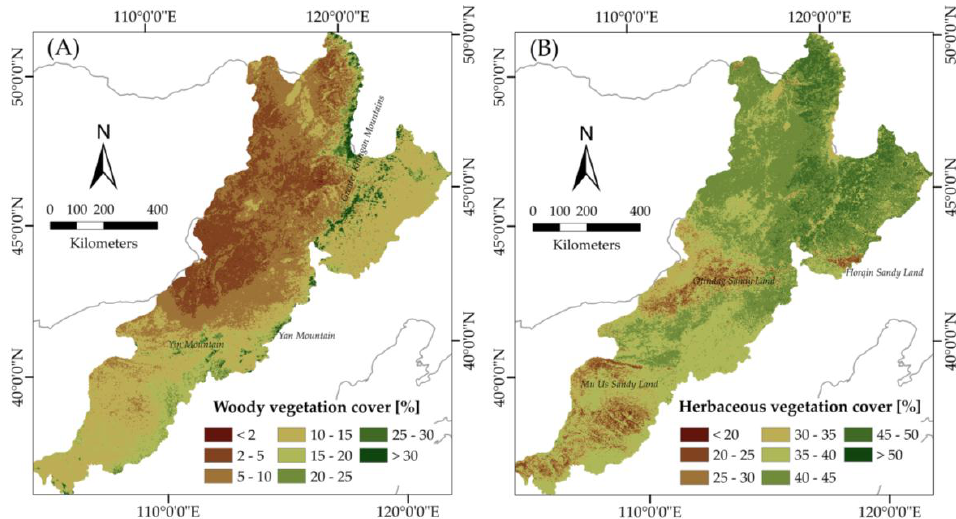
Figure 5. Fractional coverage map of ( A ) woody vegetation and ( B ) herbaceous vegetation for the East Asia steppe (2012 growing season).